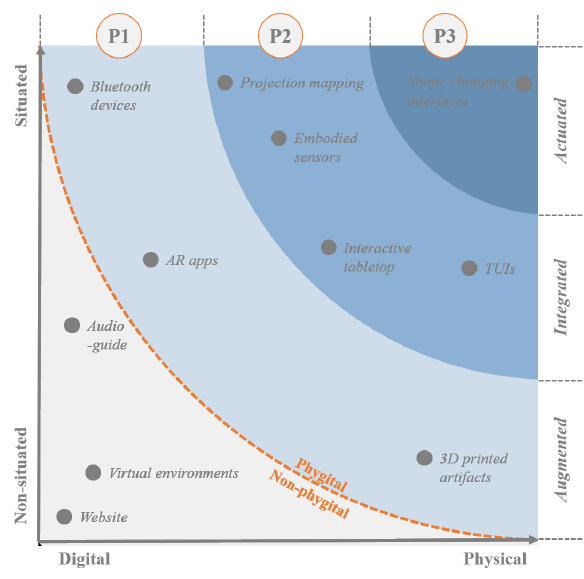
Figure 2 . Phygital Heritage classification (from (Nofal et al.,